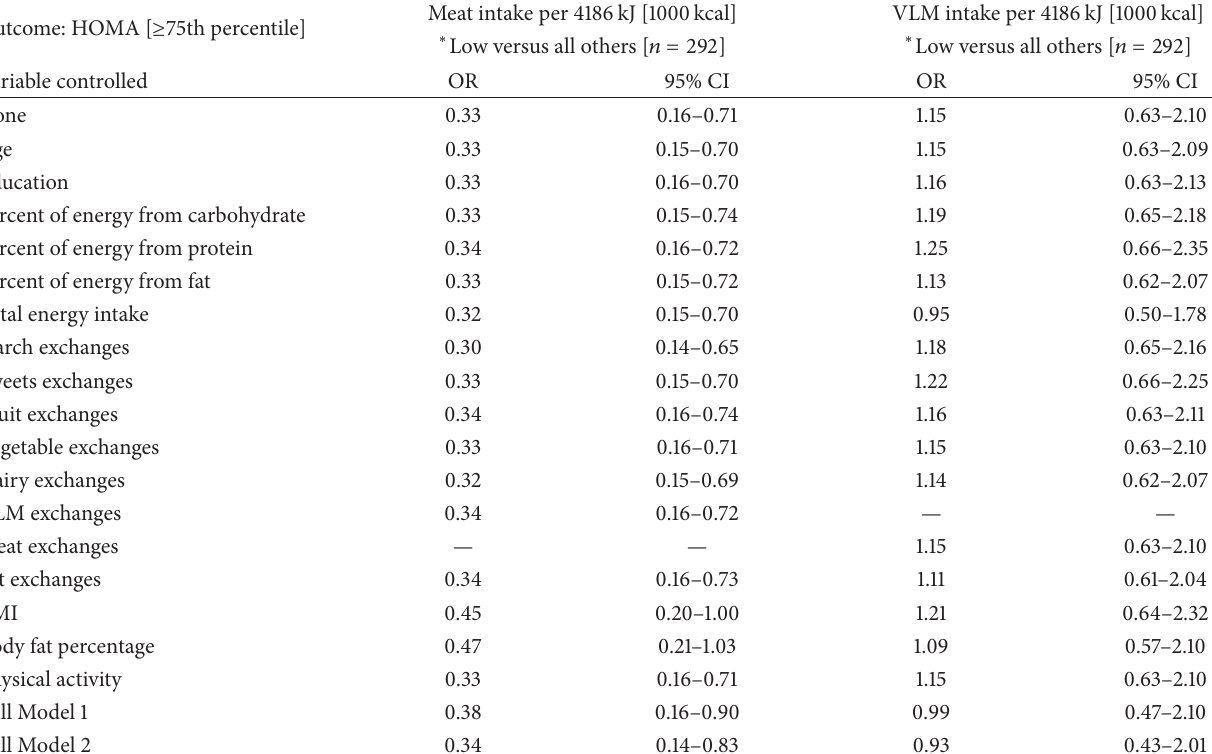
Table 4: Odds of insulin resistance [HOMA-IR ≥ 75th percentile] in women with low meat or low VLM intake compared to women with moderate to high